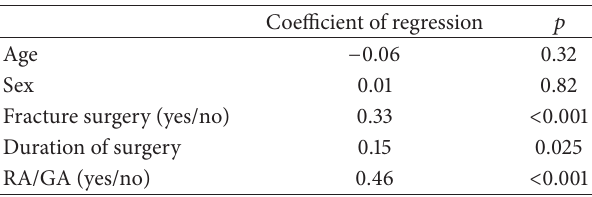
Table 3: Multiple regression on